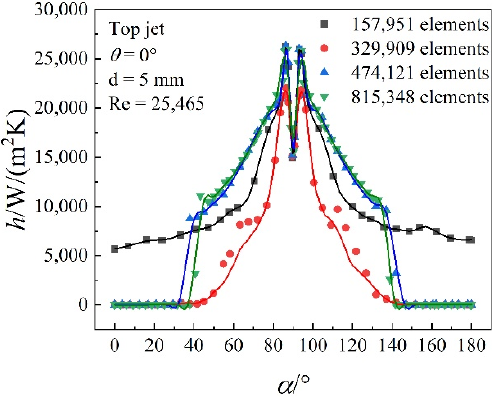
Figure 3. Distribution of the local heat transfer coefficients ( h ) in circumferential direction angle ( α ) of steel tube with different elements.